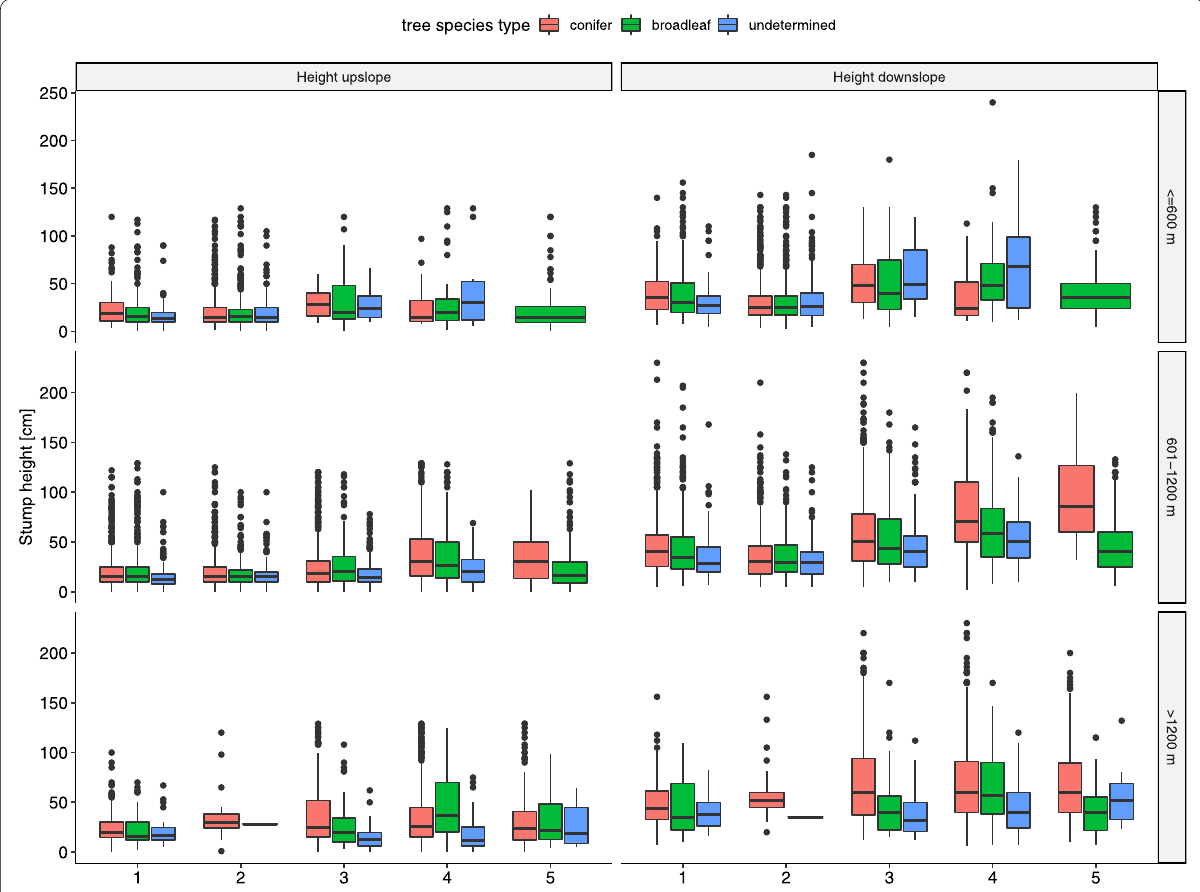
Fig. 6 Data from the NFI5 stump inventory for 6961 inventoried stumps on heights measured on the upslope and the downslope facing sides separately for conifers, broad-leaves, and undetermined species stratified by five forest regions and three elevation classes ( > 1200 m). The forest region (or production region) is used in the Swiss NFI to identify five regions with relatively homogeneous growth and wood production conditions: 1, Jura; 2, Plateau; 3, Pre-Alps; 4, Alps; and 5, Southern